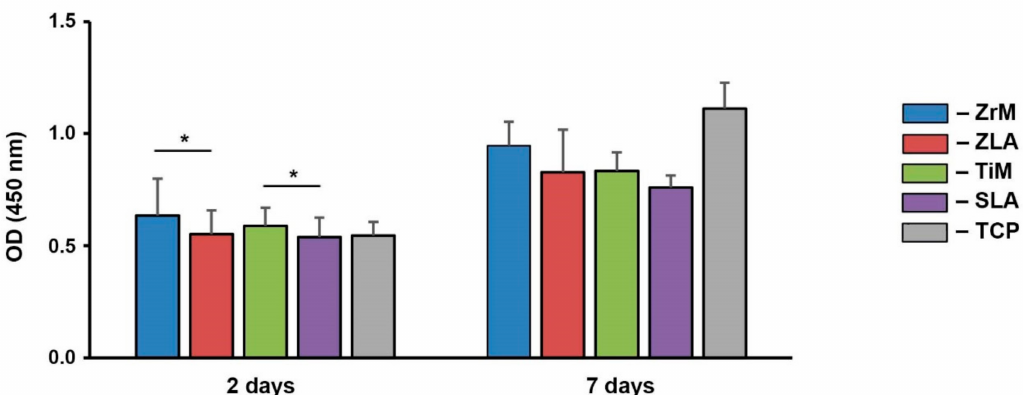
Figure 1. Proliferation/viability of primary human gingival fibroblasts grown on different surfaces. hGFs were cultured on smooth machined zirconia (ZrM), sand-blasted acid-etched moderately rough zirconia (ZLA), smooth machined titanium (TiM), sand-blasted acid-etched moderately rough titanium (SLA) surfaces, and tissue culture plastic (TCP). Cell proliferation/viability was measured by CCK-8 method after 2 and 7 days of culture. Y -axis shows the optical density values measured at 450 nm. Data are presented as mean ± SEM of 8 independent experiments with cells isolated from 8 different healthy donors. *—significant difference between the groups ( p ≤